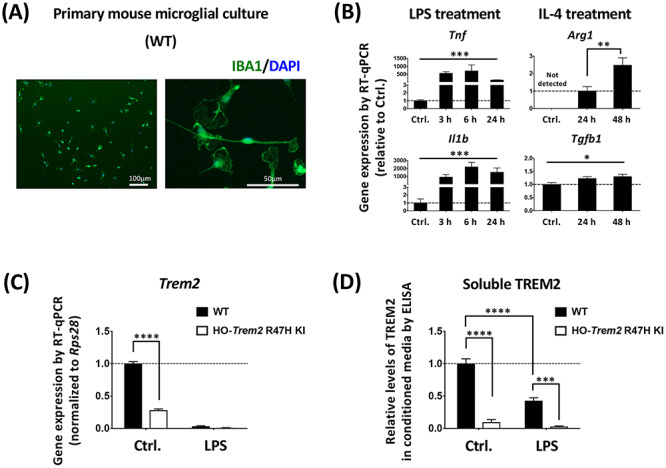
LPS suppression of Trem2 in primary microglia. (A) Left: primary microglia stained with an antibody against IBA1 and DAPI. Right: a higher-magnification image showing the morphology of microglia in vitro. (B) Pro- and anti-inflammatory gene expression changes in primary microglia with either LPS or IL-4 treatment. N = 3–6 independent experiments. Data shown as mean ± SEM. One-way ANOVA showed a significant effect of treatment for Tnf, Il1b and Tgfb1. Arg1 was not detected under control conditions, and so Student’s t-test was used to test pairwise significance between 24 and 48 h of IL-4 treatment; *P < 0.05, **P < 0.01, ***P < 0.001. (C) Expression of Trem2. N = 6 mice per genotype. Data shown as mean ± SEM. Two-way ANOVA with significant main effect of both LPS-treatment and genotype, and a significant interaction between treatment and genotype, so Sidak’s post hoc tests were performed to test pairwise significance between the genotypes within a treatment group, marked above individual groups. The interaction reflects a lack of effect of genotype in the LPS treated microglia. ***P < 0.001. (D) ELISA analysis of soluble TREM2 levels in the microglial supernatants. Soluble TREM2 levels were normalized to the expression levels of three housekeeping genes, H3f3b, Arf1 and Rps28 assessed by RT-qPCR. N = 3–4 mice per genotype. Data shown as mean ± SEM. Two-way ANOVA with significant main effect of both LPS-treatment and genotype, and a significant interaction between treatment and genotype (P = 0.0002). Thus Sidak’s post hoc tests were performed to test pairwise significance between the four groups, marked above individual groups. ***P < 0.001, ****P < 0.0001.